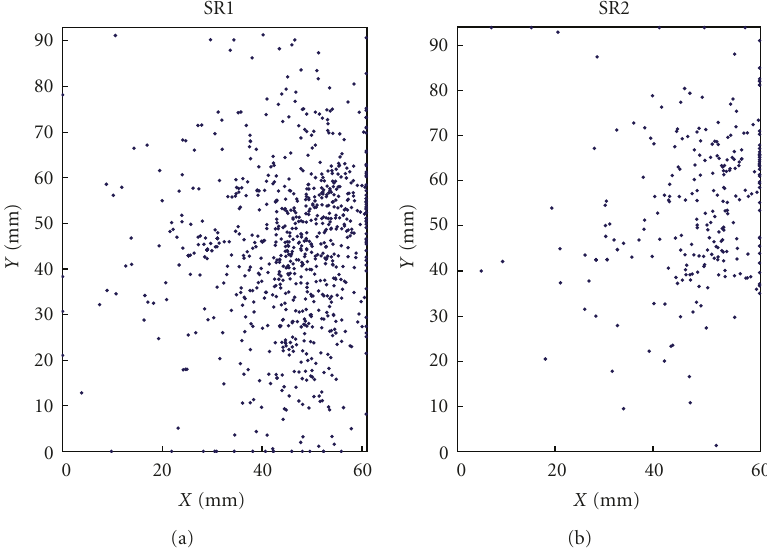
Figure 14: AE locations calculated with classic algorithm on SR1 and SR2 without clustering analysis and SVM technique.